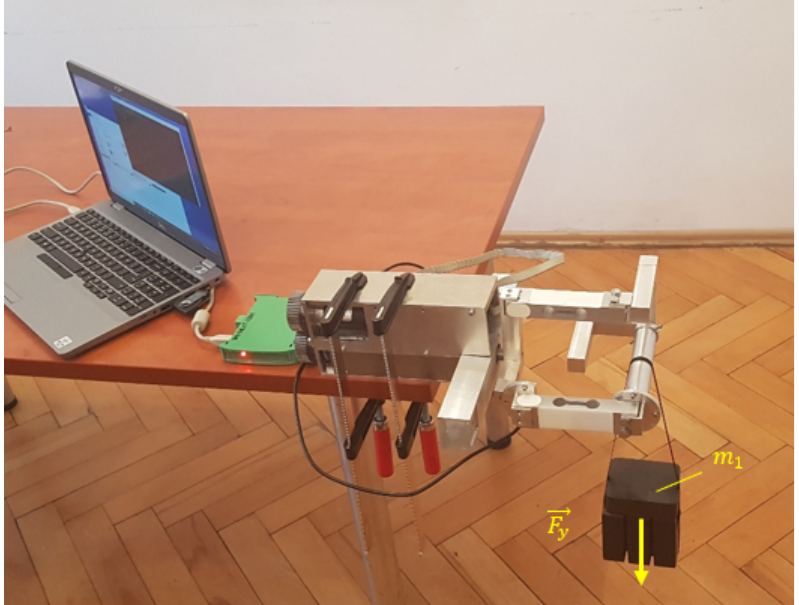
Figure 14. First experimental research of sensor grip (SG): applied m 1 = 5 kg load F y in y direction.